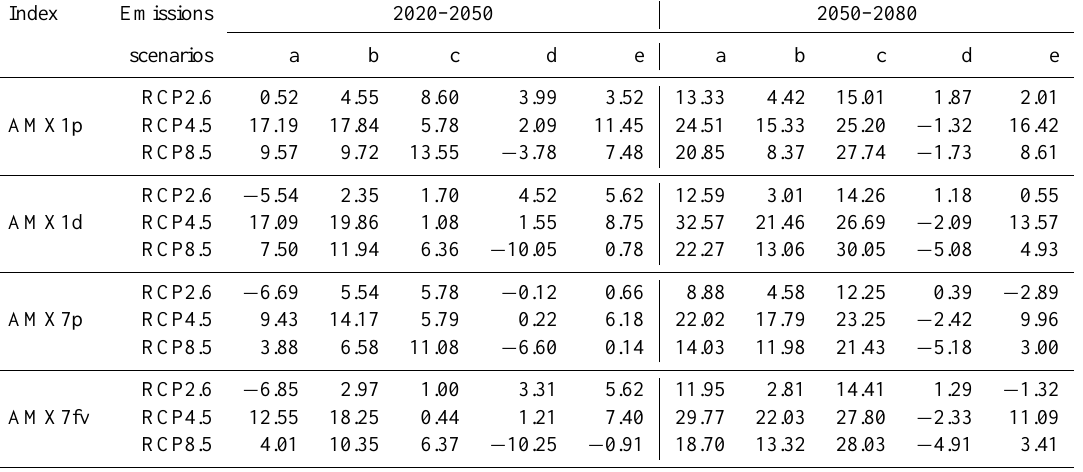
Table 2. Percentage changes (%) in AMX1p, AMX7p, AMX1d and AMX7fv under different scenarios (relative to the baseline period